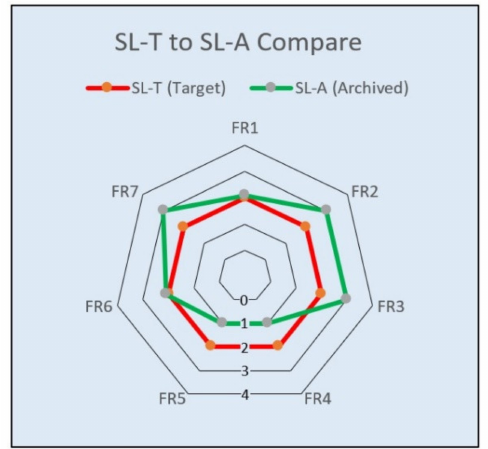
Figure 12. SL-T to SL-A relationship spider